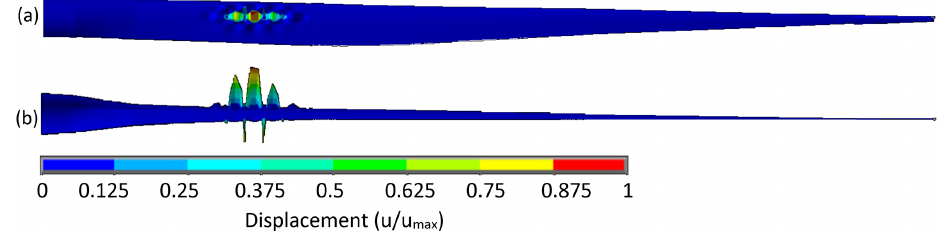
Figure 12. Displacement plot of most critical buckling mode for optimized BAR-DRC design viewed from the (a) suction side and (b) trail- ing